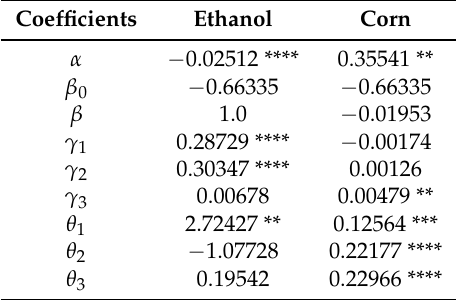
Table 7. The VECM for the ETH-COR pair in P 3 . Significance levels: 10% (*), 5% (**), 1% (***) and 0.1%